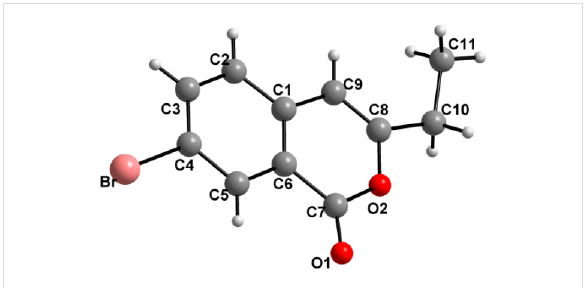
Figure 5: Molecular structure of 33 . Selected bond lengths [Å] with estimated standard deviations are given in parentheses: O2–C8 1.377(6), C8–C10 1.492(6).